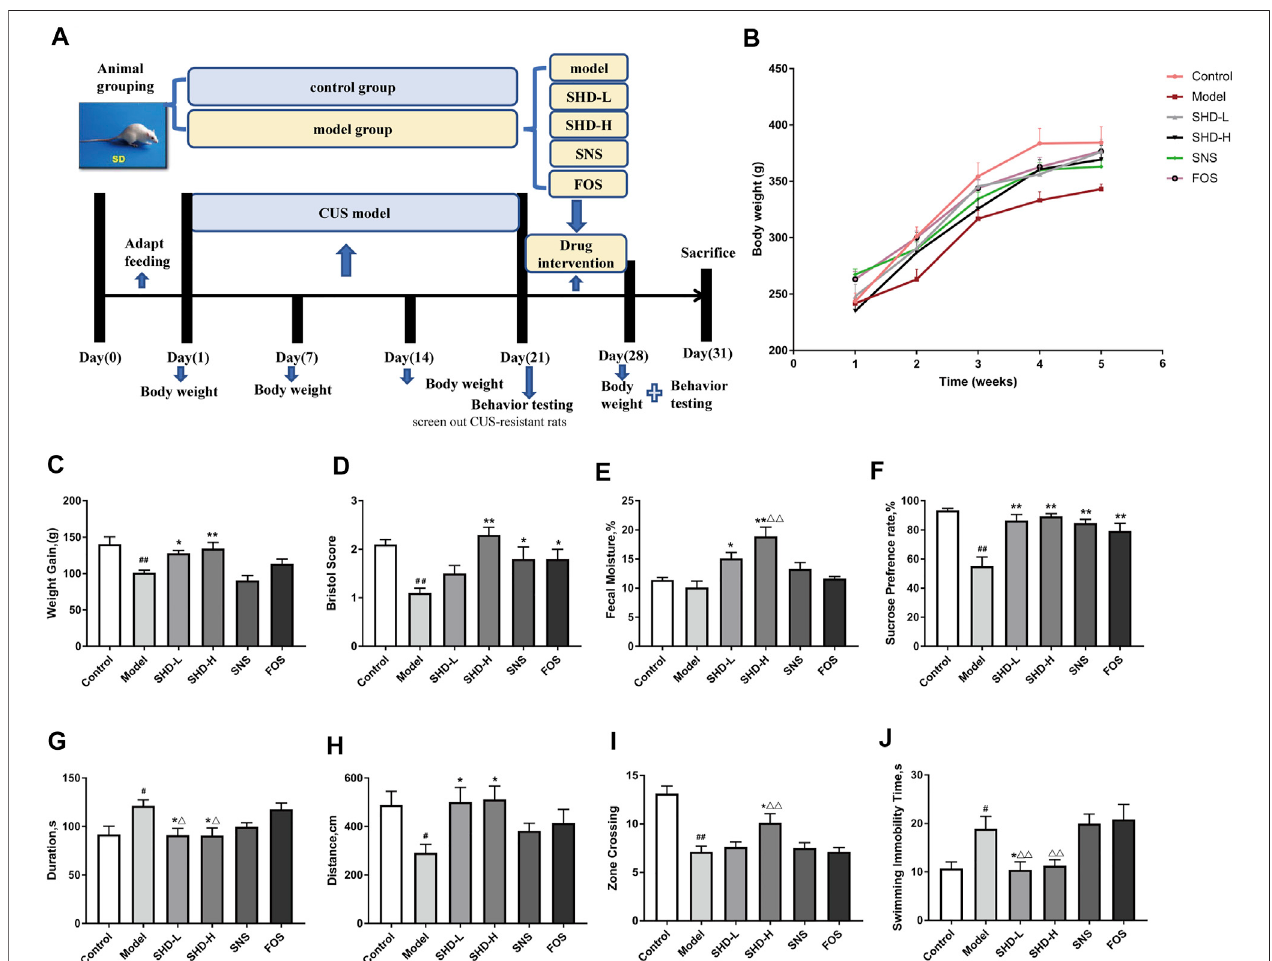
FIGURE 2 | Schematic diagram of the experimental procedures used in this study and the effects of SHD on the weight, fecal traits, and depressive-like behaviors of chronic unpredictable stress (CUS) model rats. (A) An experimental fl owchart detailing the feeding, grouping, drug interventions, and measuring of the rats. (B) Changesin thebody weights oftheCUS model rats( n (cid:2) 8). (C) Effect ofSHD onthe weight gainsexperienced bytheCUS model rats( n (cid:2) 8 – 9). (D) Effect ofSHDon the Bristol evaluation scores for the CUS model rats ( n (cid:2) 10). (E) Effect of SHD on the fecal moisture content in the CUS model rats ( n (cid:2) 5). (F) The sucrose preference rate from the sucrose preference test (SPT) ( n (cid:2) 8). (G) The stationary time observed during the open fi eld test (OFT) ( n (cid:2) 8). (H) The total movement distance observed during the OFT( n (cid:2) 8). (I) Thenumber ofcentralareas crossing thelattice during theOFT ( n (cid:2) 8). (J) Theimmobilitytime observedduring theforced swimming test (FST) ( n (cid:2) 8).Thedataareexpressedasthemean ± SEM. # p < 0.05, ## p < 0.01 vs. thecontrolgroup. *p < 0.05, **p < 0.01 vs .themodelgroup. Δ p < 0.05, ΔΔ p < 0.01 vs.